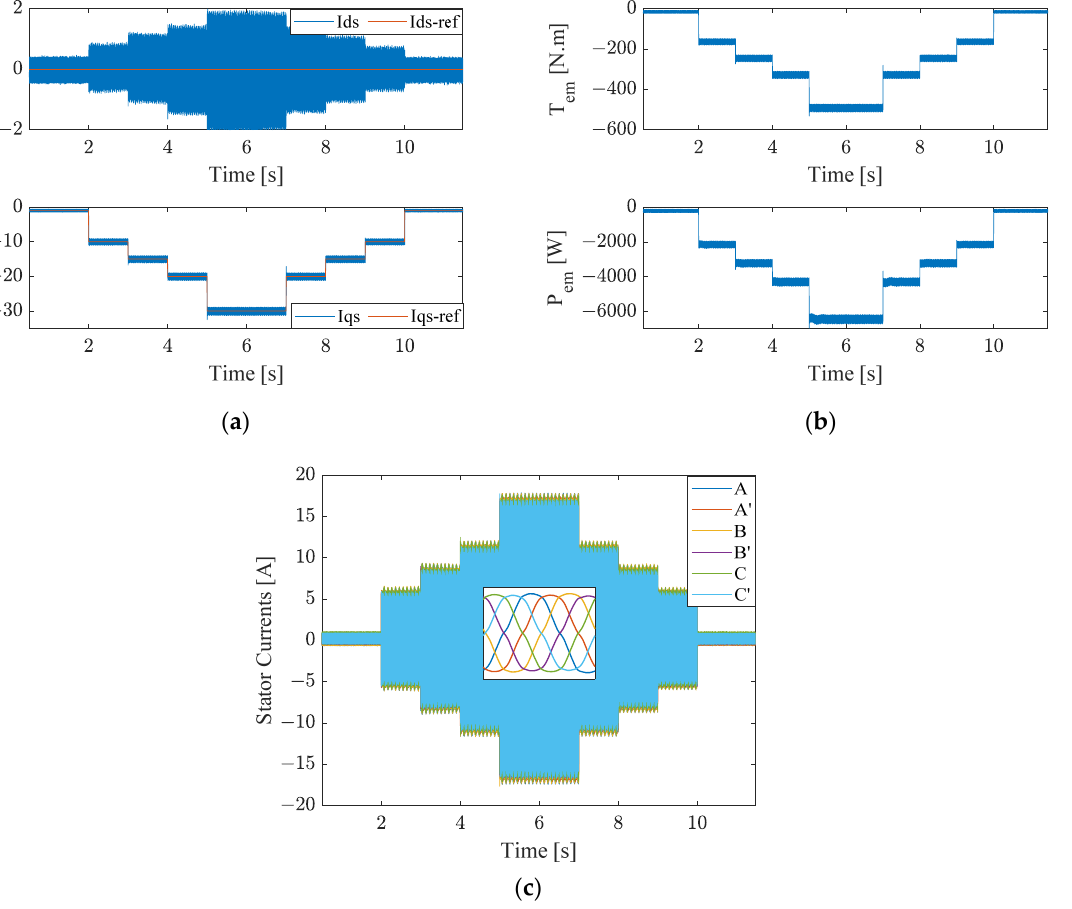
Figure 7. Healthy mode results with PI controller: ( a ) dq currents; ( b ) electromagnetic torque and electromagnetic power; ( c ) stator currents.